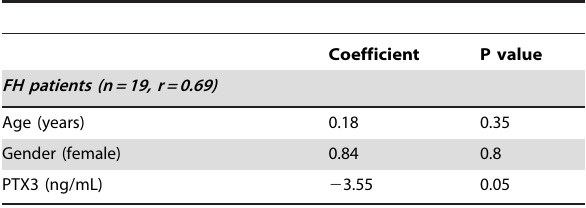
Table 3. Multiple regression model predicting LDL apheresis vintage in FH patients.